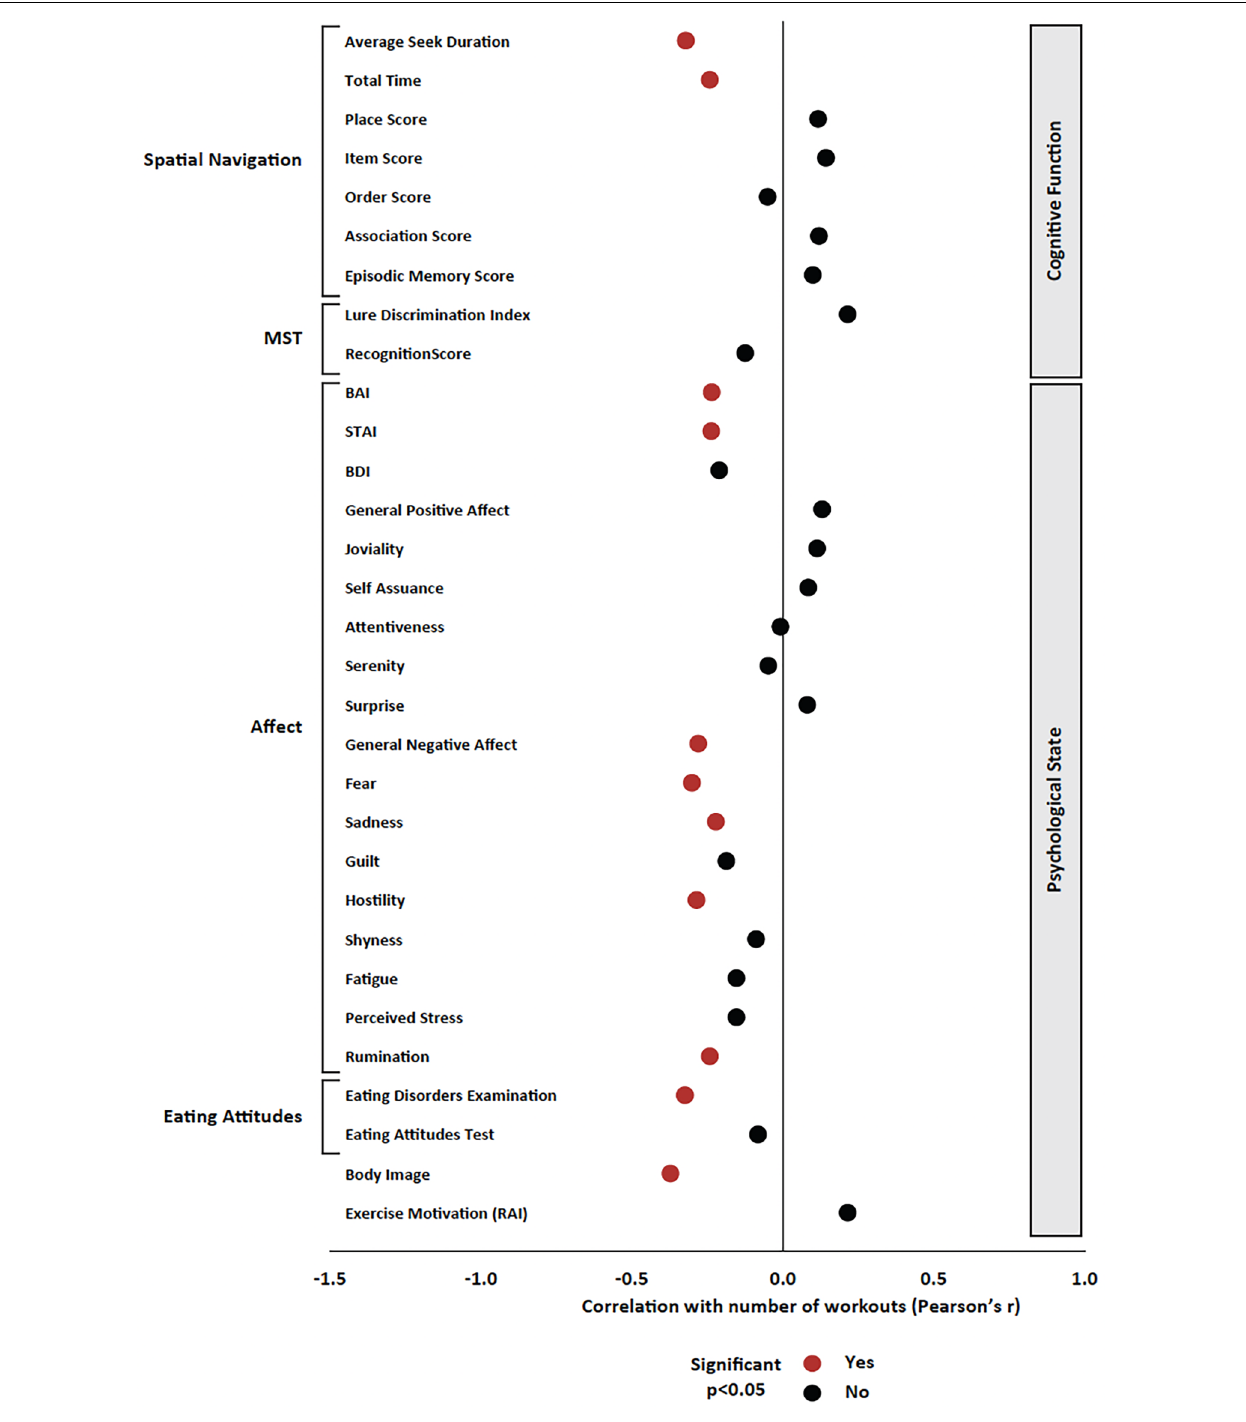
FIGURE 4 | Pearson’s product-moment correlation between the total number of cycling workouts and all variables of interest. Pearson’s r is presented on the x axis, and significant effects ( p < 0.05) are presented in red; non-significant effects are presented in black.